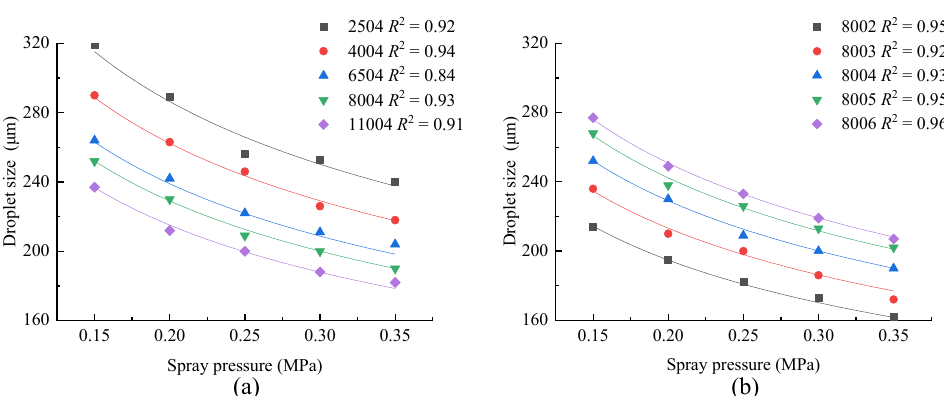
Figure 7. Fitting curves and values of droplet size vs. equivalent orifice diameter. The relationship between the spray angle and the droplet size at different pressure values with the same equivalent orifice diameter is shown in Figure 8. The droplet size along the Z-axis decreased with the increase in the spray angle. At constant spray pressure and flow rate, the increase in the spray angle was observed to lead to a decrease in the thickness of the liquid film after liquid ejection, with the thickness of the film was posi- tively correlated with the size of the droplet formed after breaking. Therefore, the larger the spray angle, the smaller the droplet size. The fitting function between the spray angle and the droplet size along the Z-axis is represented as follows: